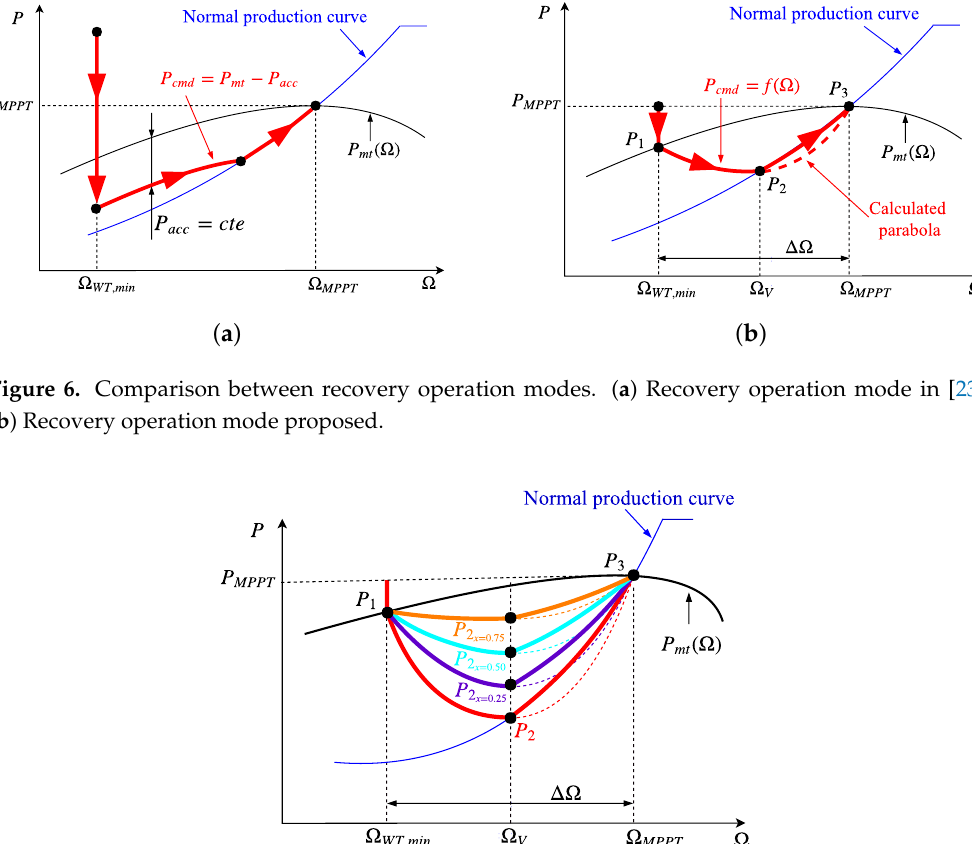
Figure 7. Different proposals for recovery operation mode